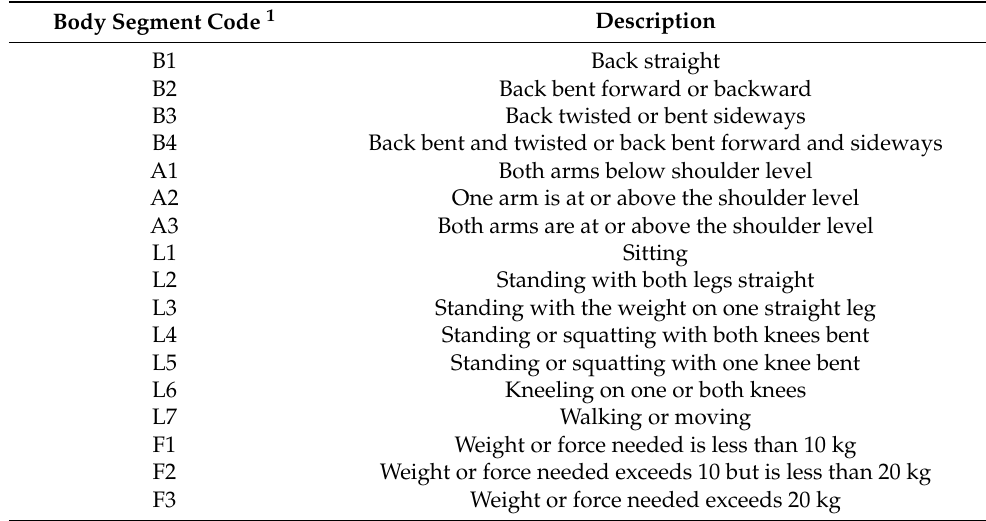
Table 2. The OWAS framework used to attribute postural codes to the main body